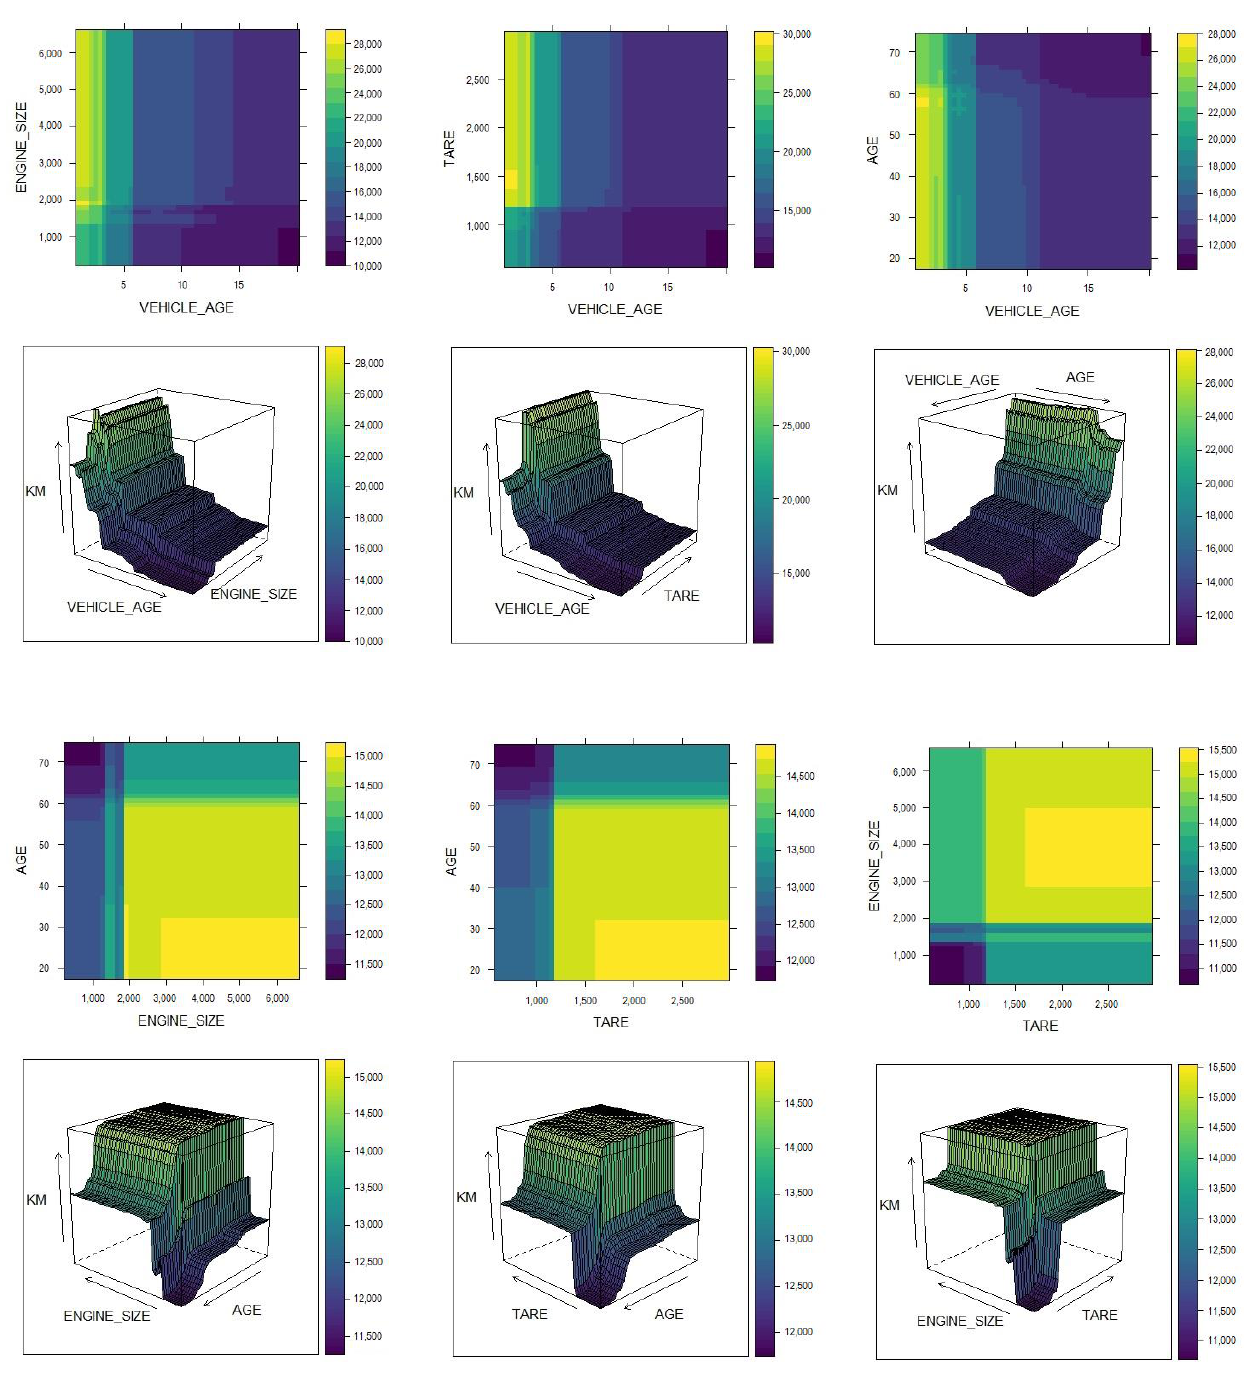
Figure 8. Partial dependence graph for the GBM.